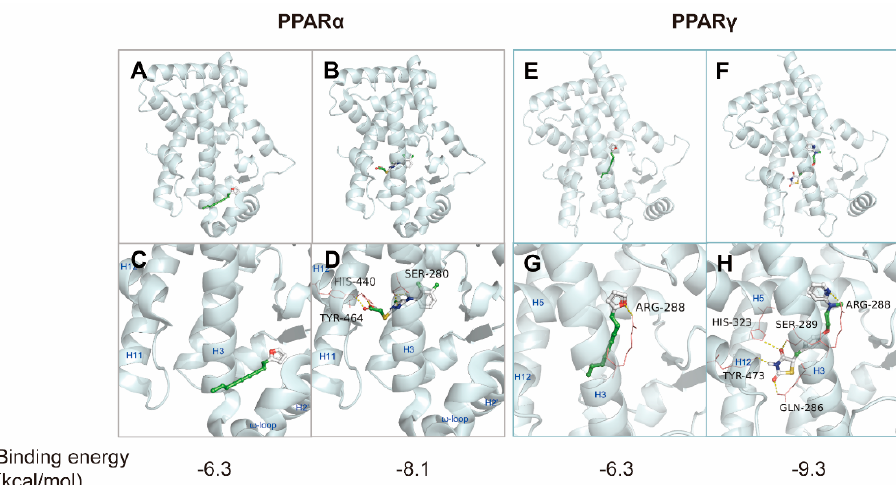
Figure 3. Molecular docking models of atractylodin and PPAR α or PPAR γ . ( A , B ) An overview of the optimal docking modes of atractylodin and WY14643 bound to the ligand binding domain (LBD) of PPAR α , respectively. ( C ) Zoomed in view of the docking mode of atractylodin ( − 6.3 kcal/mol) occupying the ω -loop region of PPAR α LBD. ( D ) Zoomed in view of the docking mode of WY14643 ( − 8.1 kcal/mol) with hydrogen bonds (yellow dotted line) formed with Ser280, His440, and Tyr464 of the PPAR α LBD. ( E , F ) An overview of the optimal docking modes of atractylodin and rosiglita- zone to the LBD of PPAR γ , respectively. ( G ) Zoomed in view of the docking mode of atractylodin ( − 6.3 kcal/mol) with a hydrogen bond (yellow dotted line) formed with Arg288 of the PPAR γ LBD. ( H ) Zoomed in view of the docking mode of rosiglitazone ( − 9.3 kcal/mol) with hydrogen bonds (yellow dotted line) formed with Ser289, Gln286, His323, Tyr473, and Arg288 of the PPAR γ LBD.